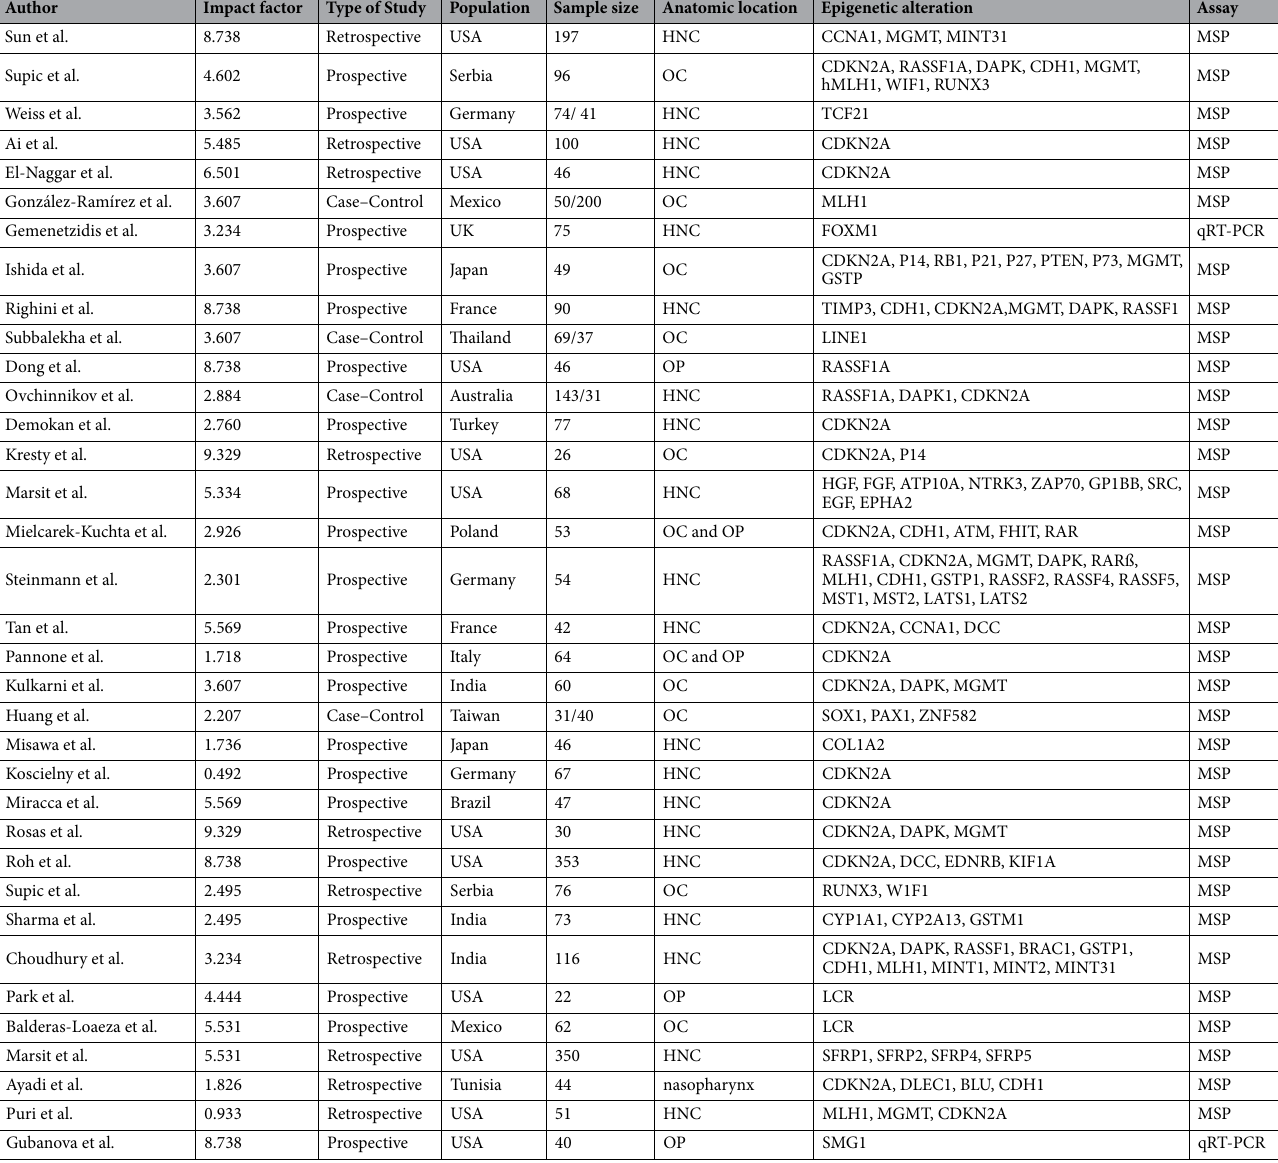
Table 1. Hypermethylation in genes associated with risk factors in patients with head and neck squamous cell carcinoma in the 85 identified studies. MSP: methylation specific PCR; OC: oral cancer; OP: oropharyngeal cancer; HNC: head and neck